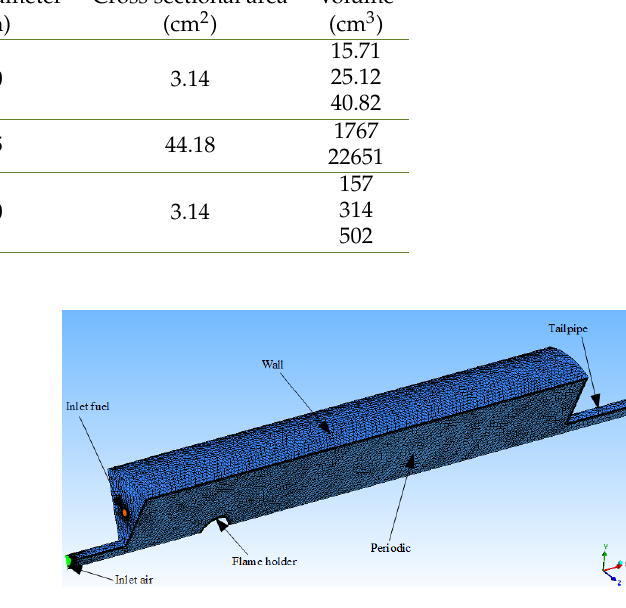
Fig. 2. Three-dimensional mesh of pulse combustor a small sector of a cylindrical domain equal to one eighth of the combustor cylinder is employed. The model used an unstructured mesh with a grid element size of 2 mm, which was reduced to 1 mm in the air and fuel inputs. The use of ear body, like a round cylinder. To accurately capture the velocity and temperature gradients near no-slip walls, the mesh resolution is improved by adding an inflating layer to the fluid-solid interface. The five inflation layers along the wall boundary and around the flame holder were